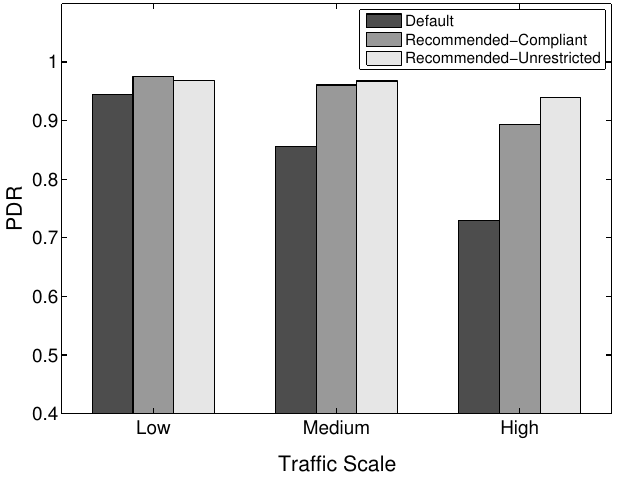
Figure 20. Comparison of overall PDR between default, Recommended-Compliant and Recommended-Unrestricted stack configurations.